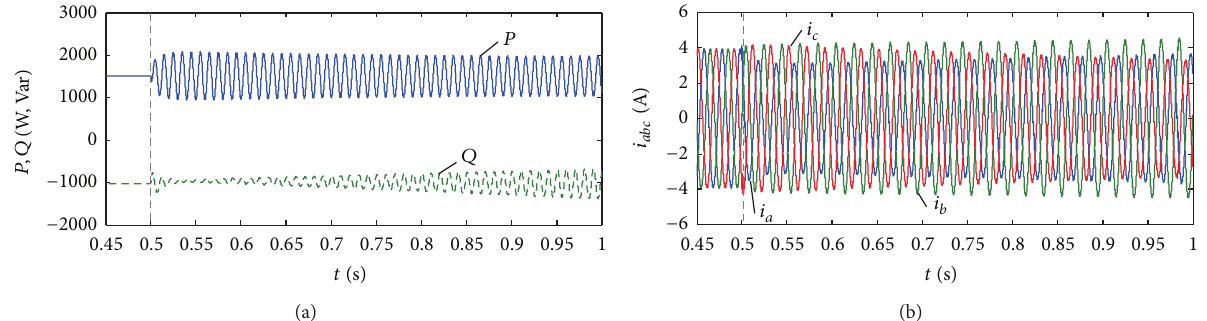
Figure 11: Sensitivity analysis of coefficient 𝛾 for power control. (a) Active and reactive power when 𝑛 = 0.2 . (b) Output current when 𝑛 = 0.2